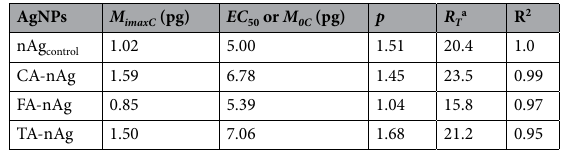
Table 4. Fitting parameters for nAg control , CA-nAg, FA-nAg and TA-nAg internalized to A549 cell based on logistic model (incubated AgNPs concentration were 0–60 μg ml −1 ). a R T = M imaxC / M 0C × 100%, was defined to reflect the efficiency of surface association AgNPs transferring to internalized AgNPs.